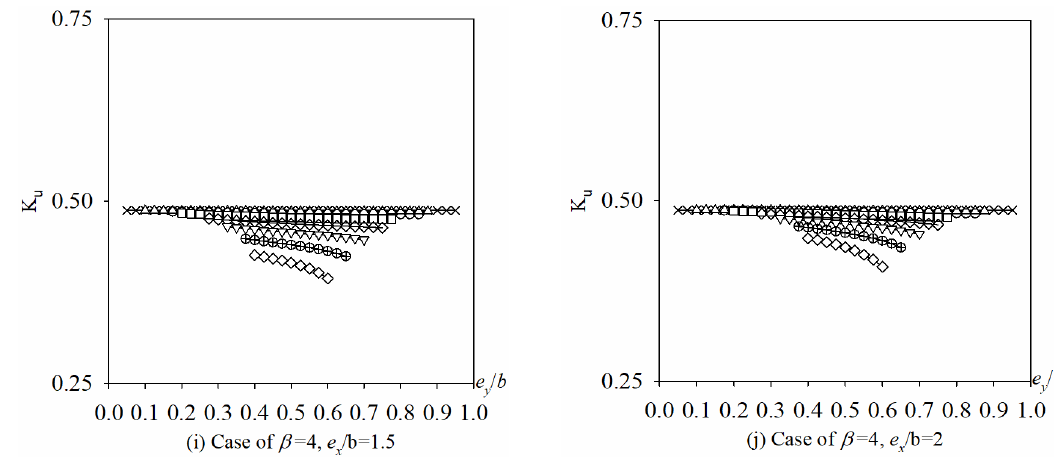
Figure 19. K u vs. e y / b for perforated rectangular plate ( β = 1, 2, 3, 4) with the BCs of 3S1F.